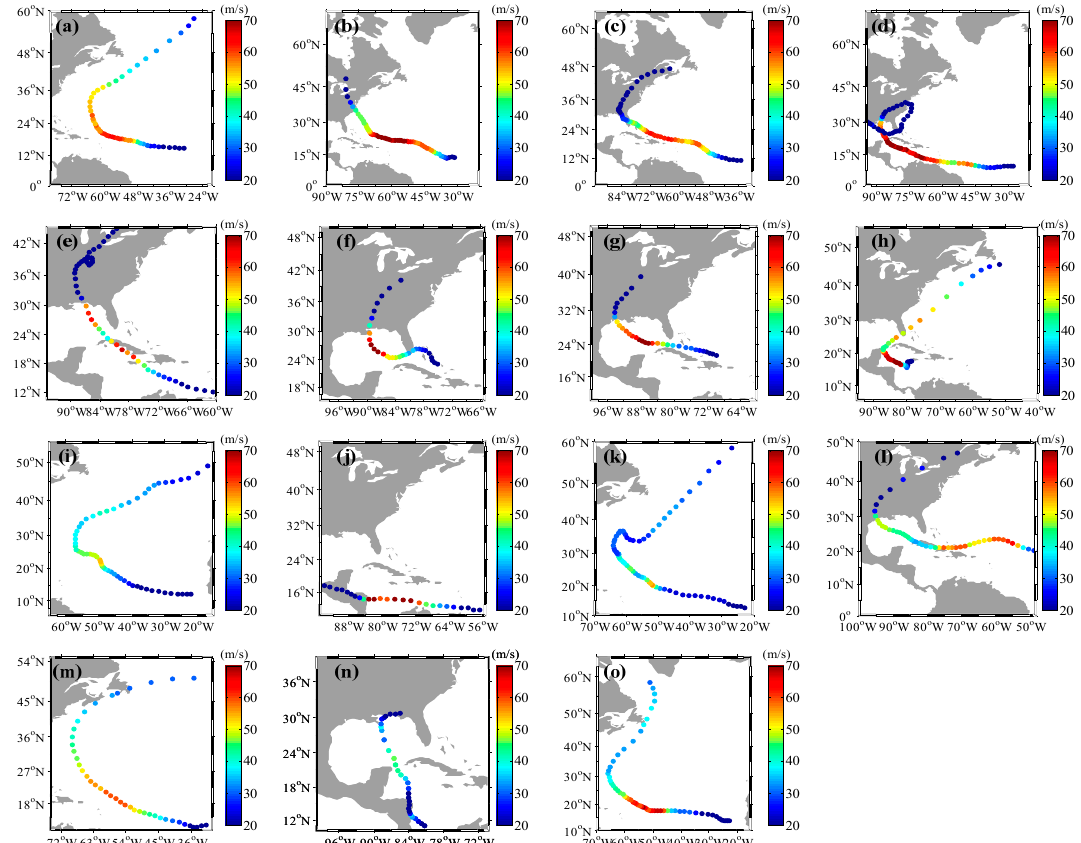
Figure 1. Best track positions and the corresponding intensity of the selected hurricanes for ( a ) Fabian,